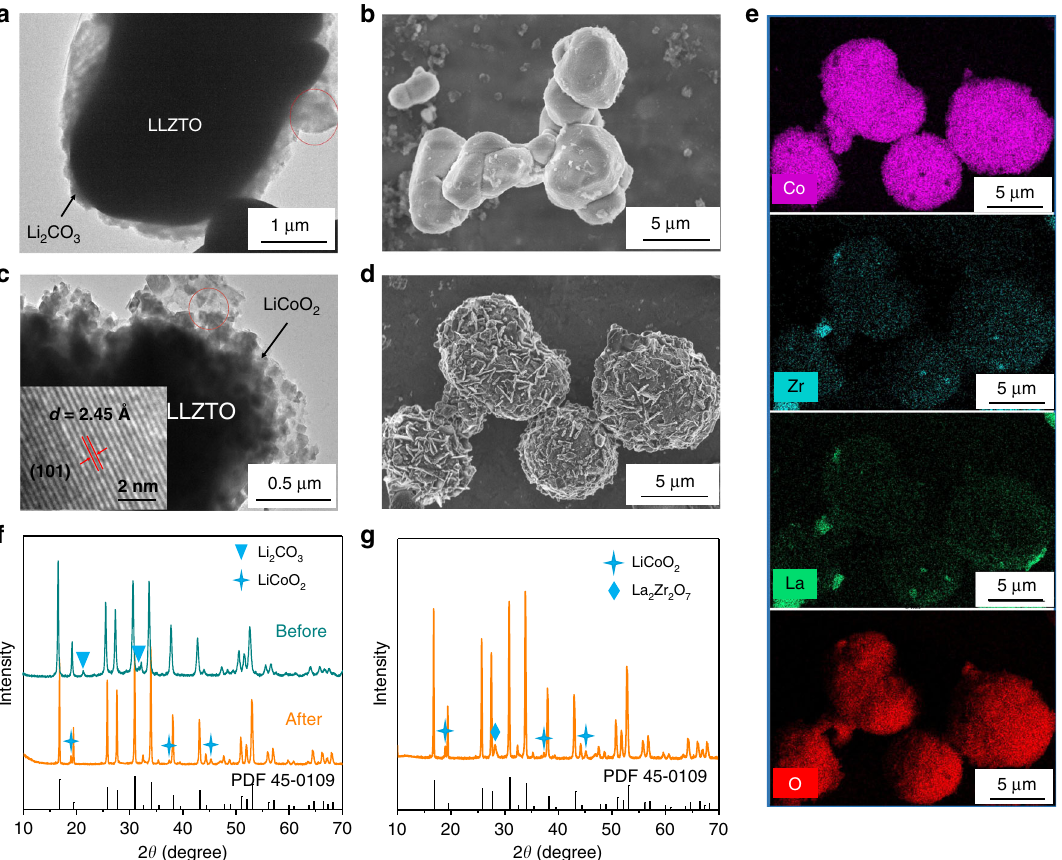
Fig. 1 Characterization of LLZTO@Li 2 CO 3 and LLZTO@LCO. a , b TEM image and SEM image of LLZTO powder exposed to air for four weeks. c , d TEM image and SEM image of LLZTO@LCO. e EDX mapping analysis of LLZTO@LCO corresponding to ( d ). f XRD patterns of LLZTO@Li 2 CO 3 and LLZTO@ LCO. g XRD pattern of materials after fi rst sintering containing impurity.